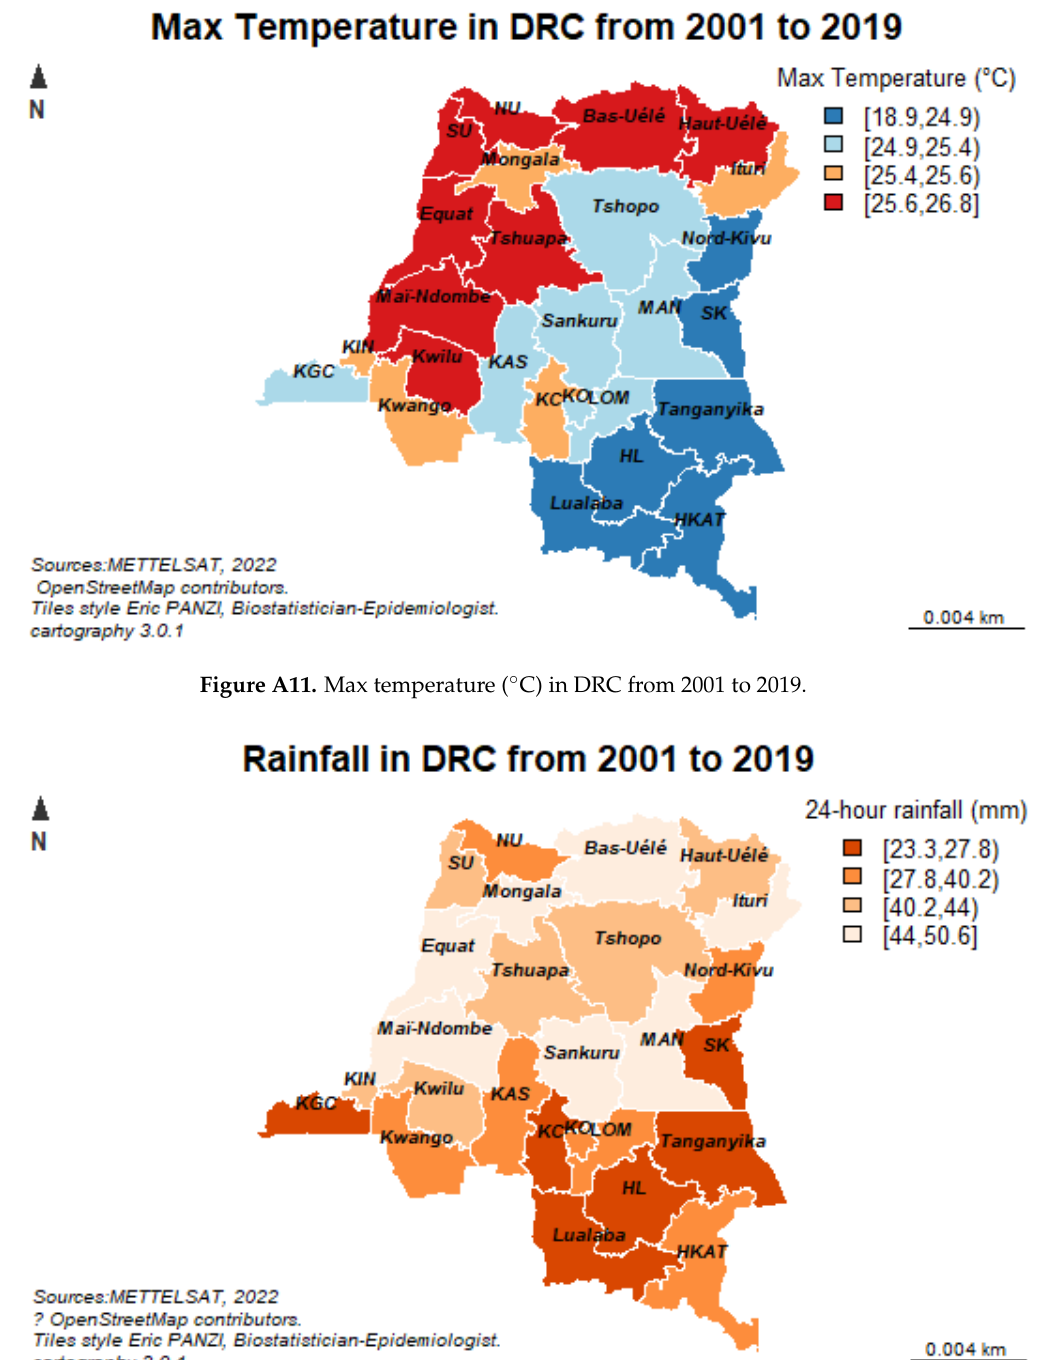
Figure A10. Speed wind (m/s) in DRC from 2001 to 2019.